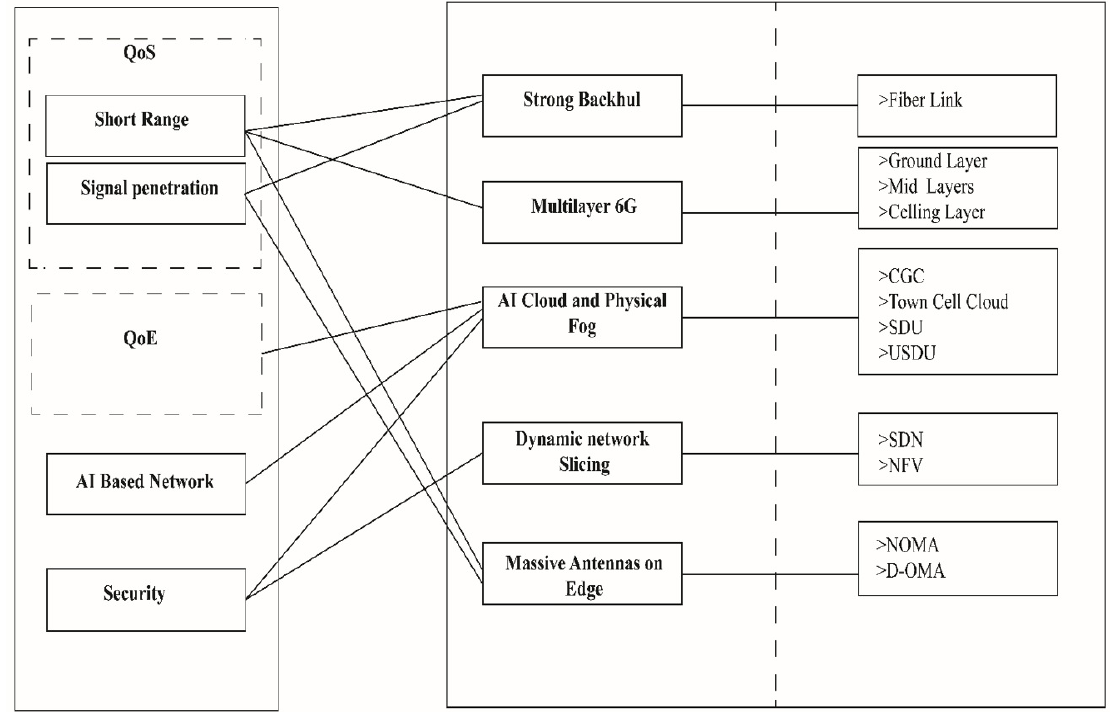
Figure 18. Major challenges resolved by Bee